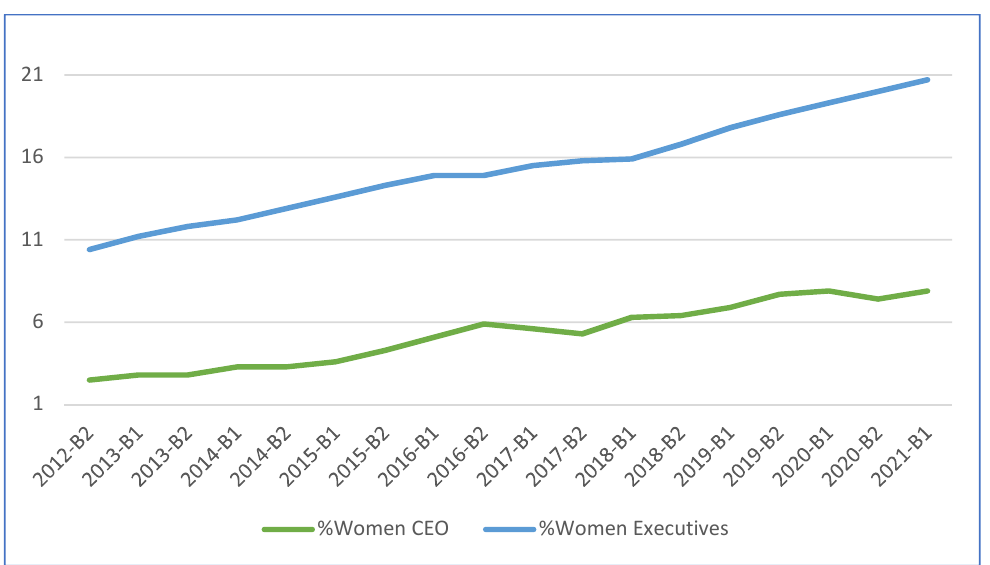
Figure 2. Percentages of women CEO and executives—EU28.